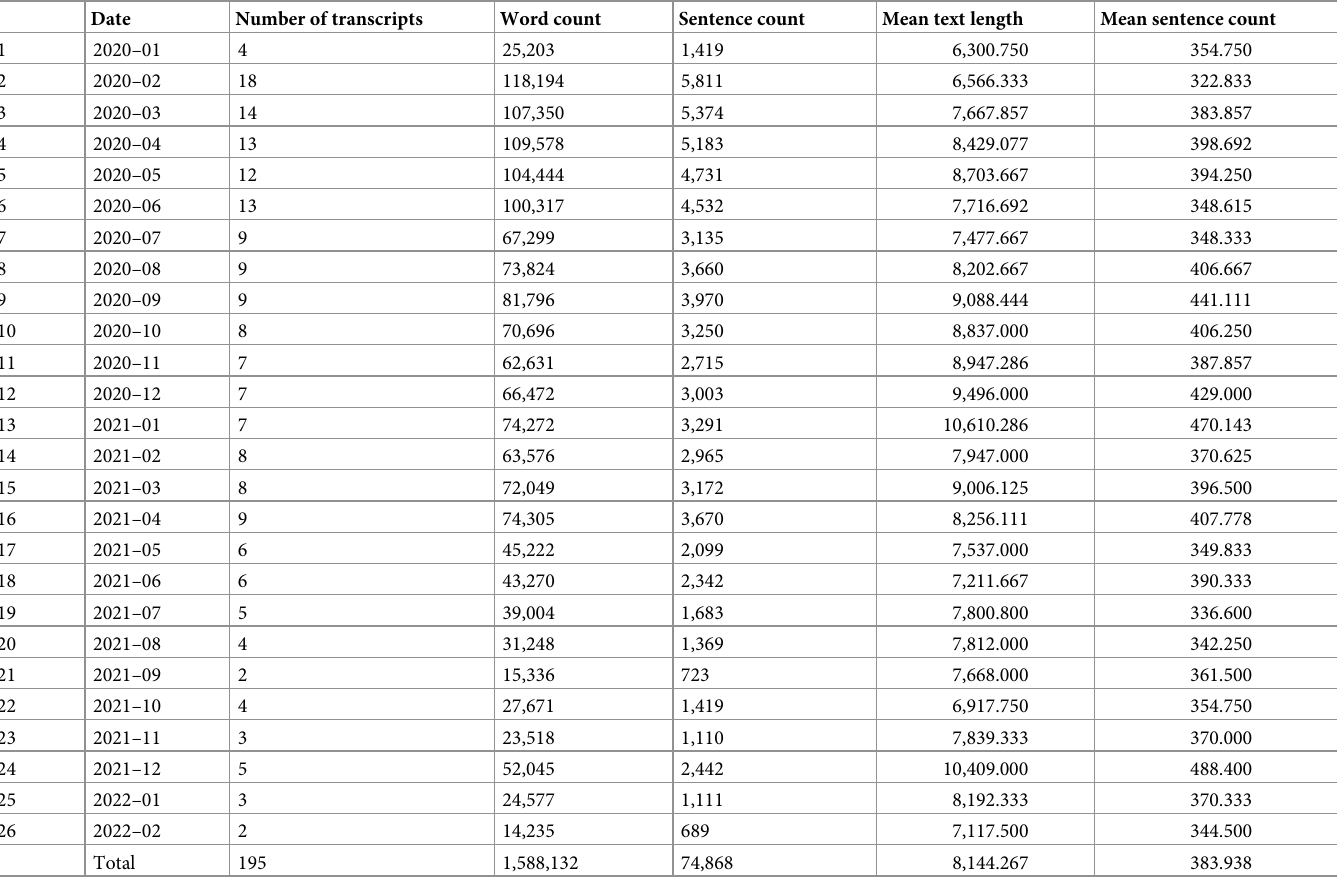
Table 1. Descriptive statistics of the WHO COVID-19 press conference